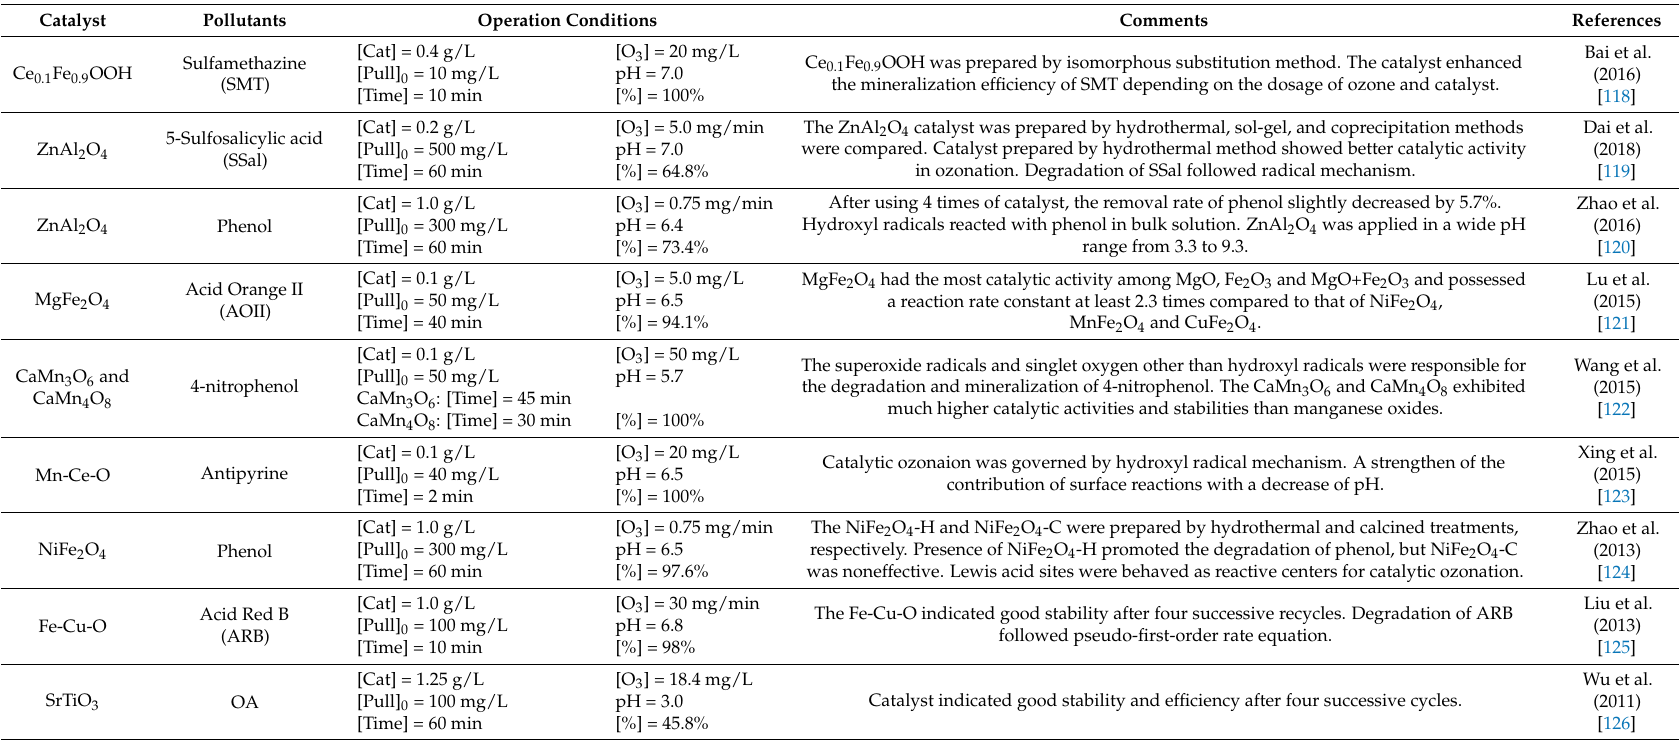
Table 8. Bimetallic oxides for catalytic ozonation